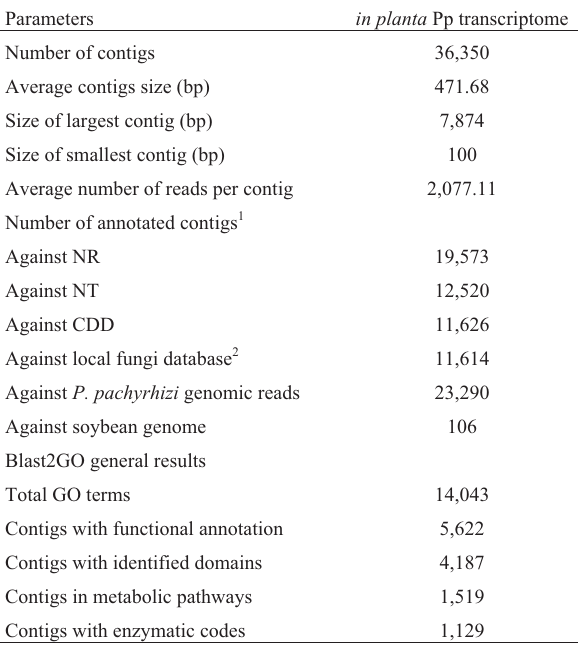
Table 1 - General statistics of the de novo assembly of RNA-Seq data.